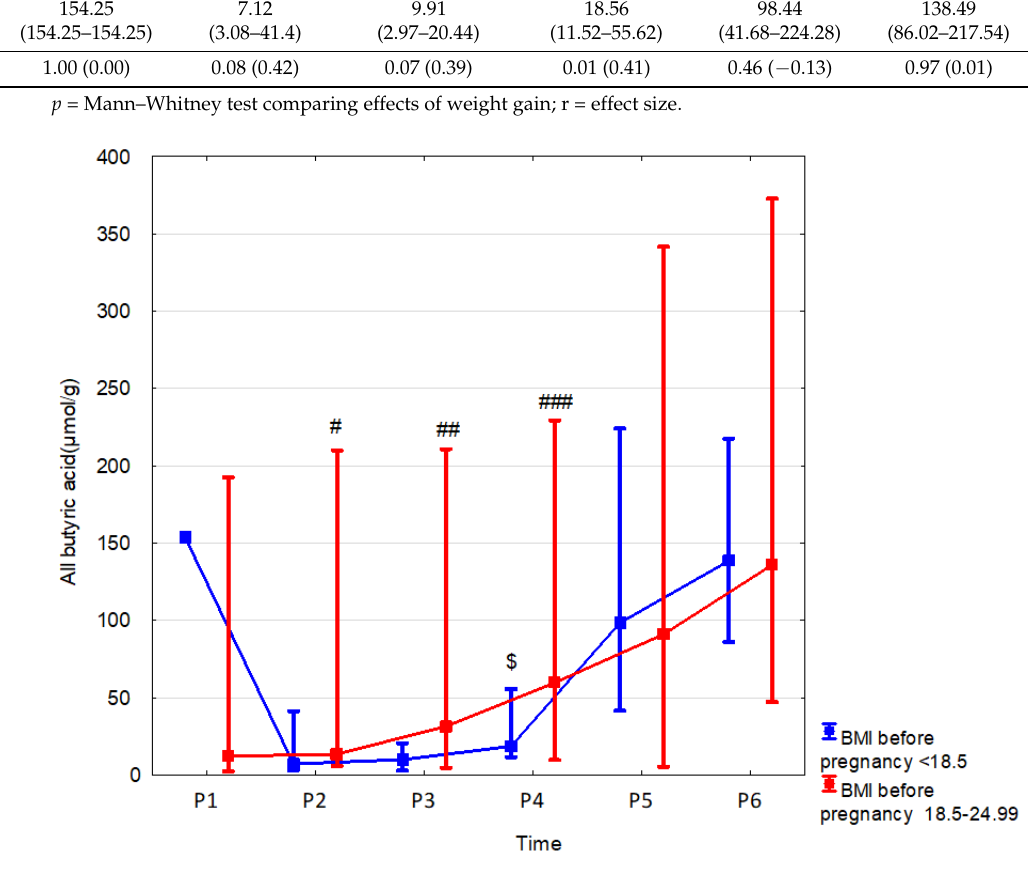
Table 8. Effect of weight gain during pregnancy on all SCFA concentrations.